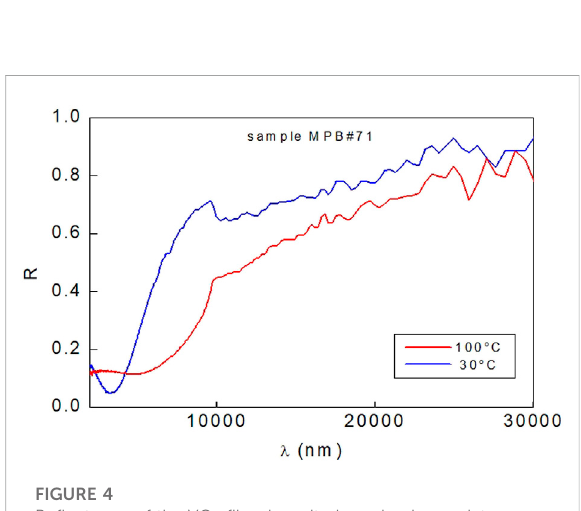
FIGURE 4 Re fl ectance of the VO 2 fi lm deposited on aluminum plate measured with